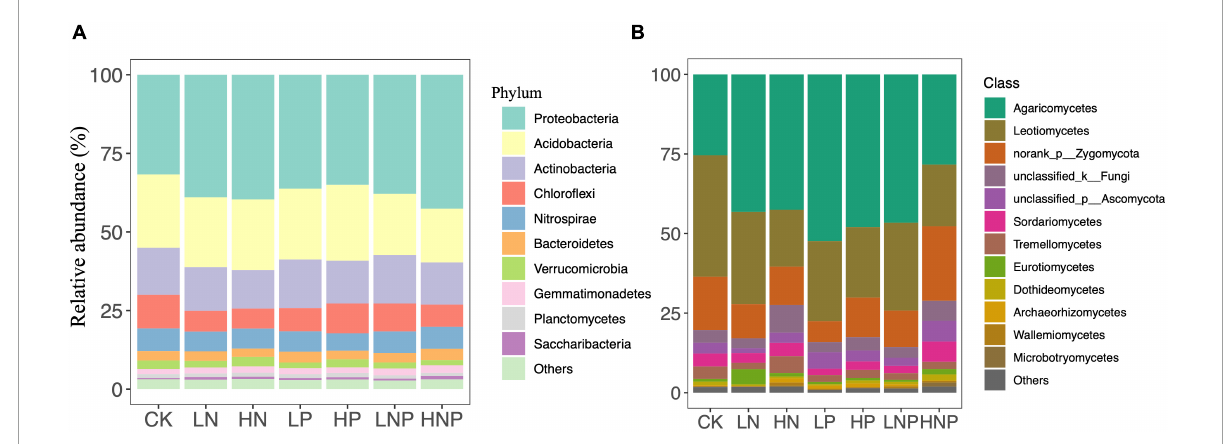
FIGURE3 Relative abundances of the soil bacterial (A) and fungal (B) groups under different nutrient additions. The rare taxa (relative abundances < 1%) are grouped into “other.” LN, low N; HN, high N; LP, low phosphorous; HP, high phosphorous; LNP, low N and low P; HNP, high N and high P; CK, control.